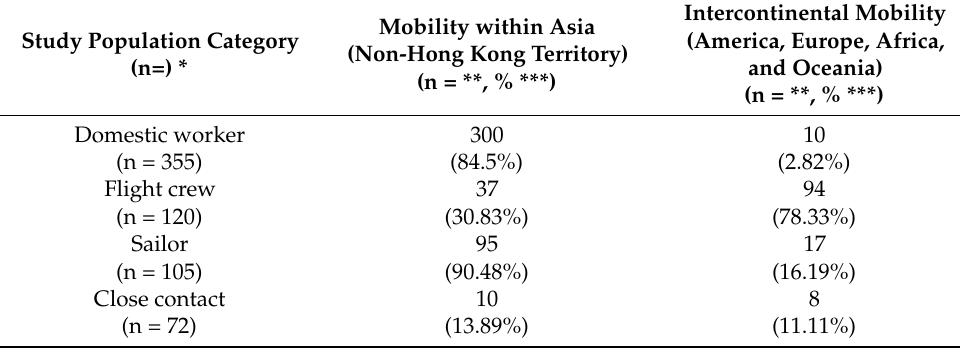
Table 6. Study Population’s Cross-sectional